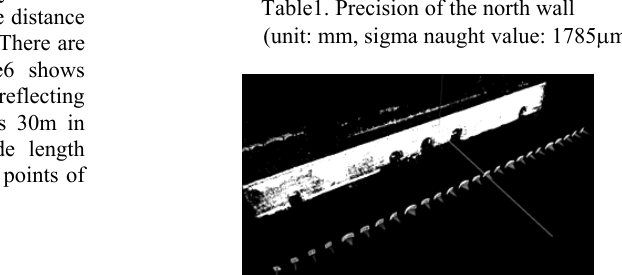
Table1. Precision of the north wall